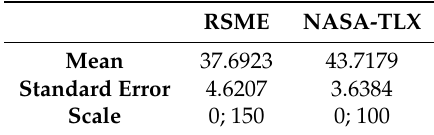
Table 4. Mean and standard error of RSME and NASA-TLX.